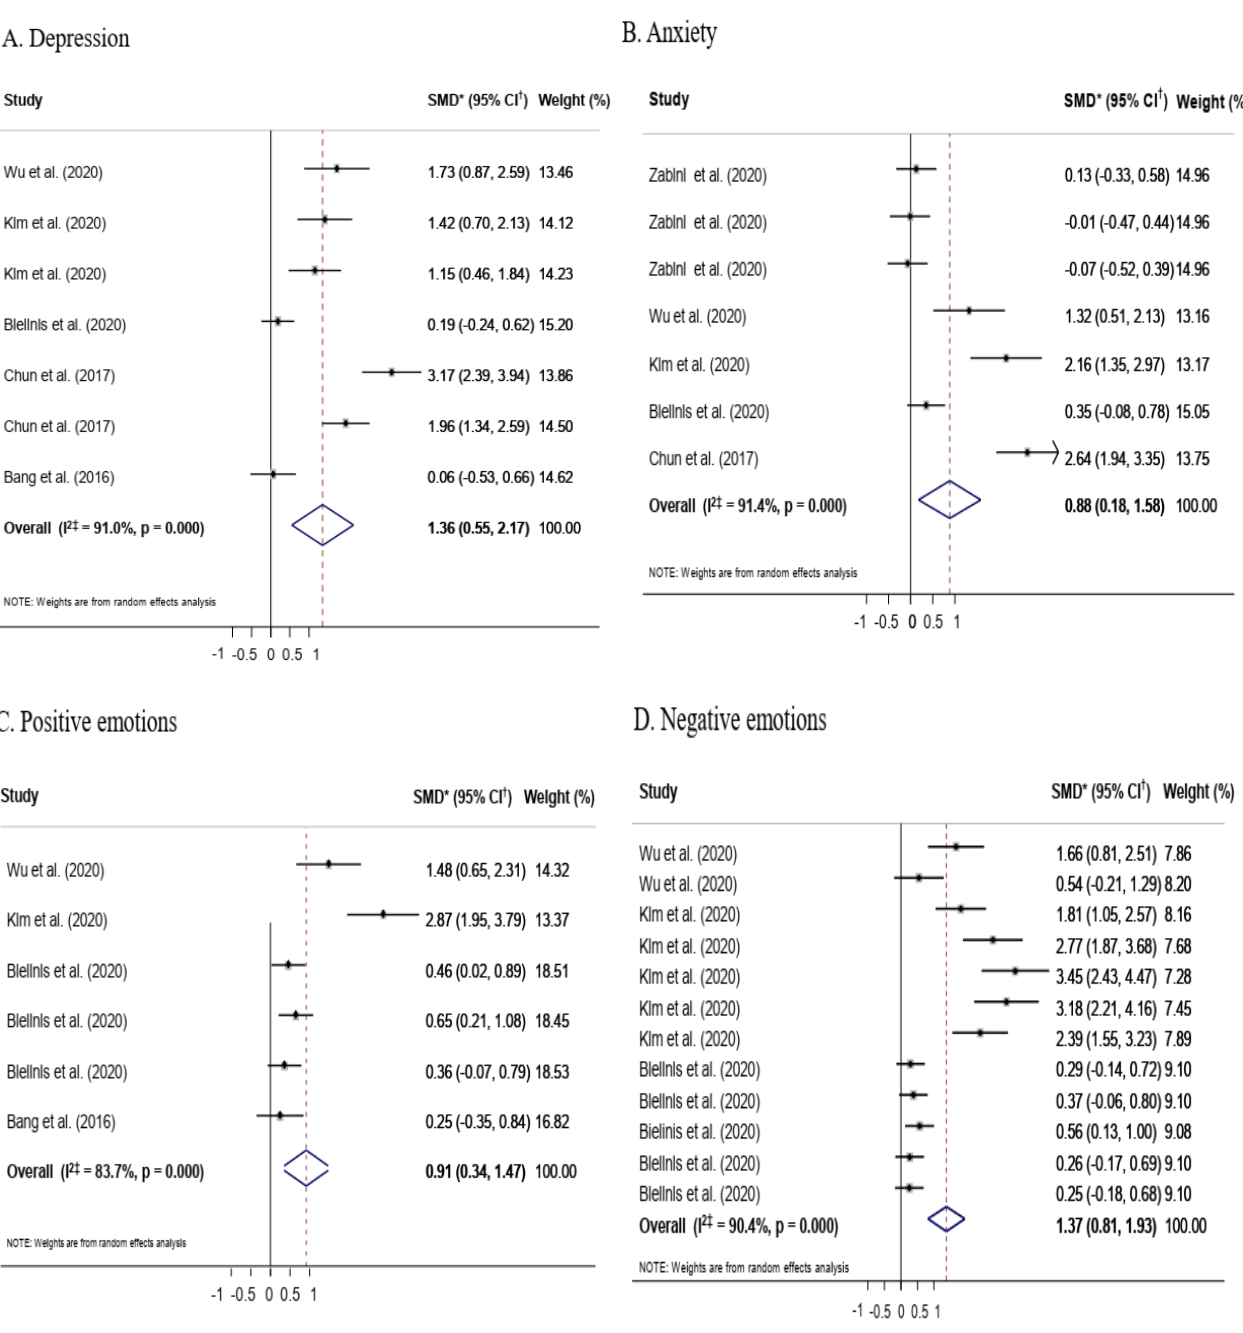
Figure 3. Effects of forest-based intervention on subgroups of mental health.